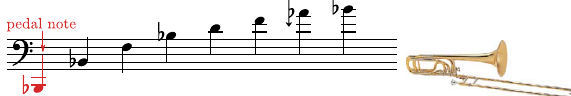
Figure 3. Natural notes playable by a trombone, i.e. without moving the slide nor activating any trigger. From left to right: B [ 1 (pedal note), B [ 2, F3, B [ 3, D4, F4, A [ 4 (naturally a bit fl at compared to an equal tempered scale), B [